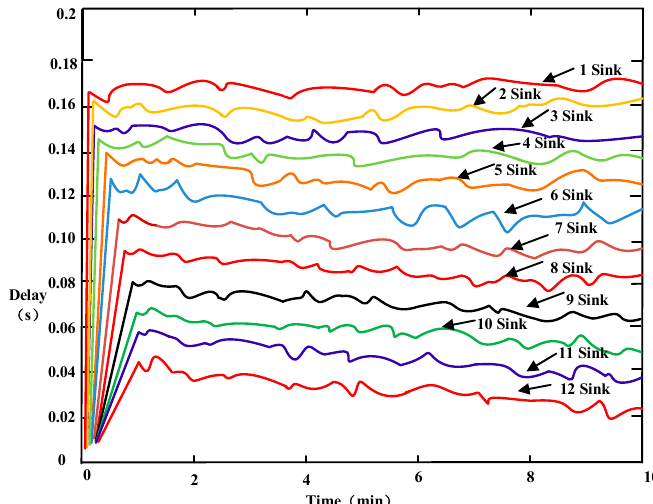
Figure 13. Comparison of data packet delay using varying numbers of sinks.